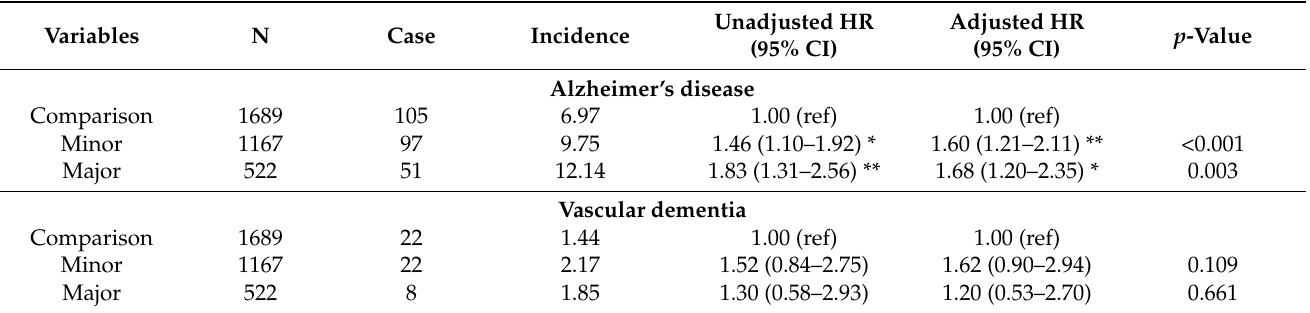
Table A9. Incidence per 1000 person-years and HR (95% CI) of specific diseases (Alzheimer’s disease and vascular dementia) according to surgery